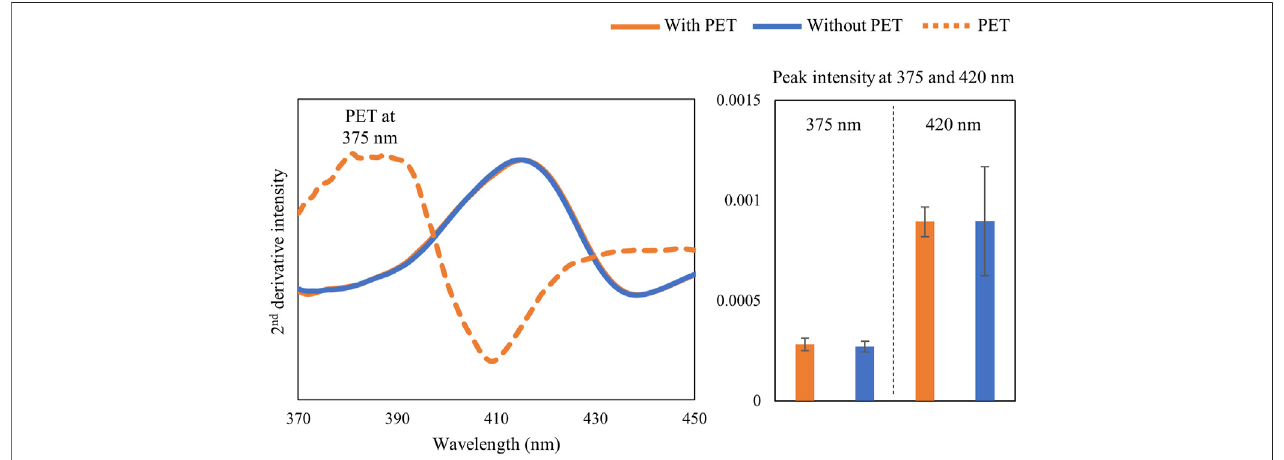
FIGURE4|(A) Saf-O-andfastgreen-stainedimagesfrom1-month( n =9)and3-month( n =6)animalswiththede fi nedrepairtissueregion. (B) Meanandstandard deviation of ICRS II component scores (comparisons by the Wilcoxon rank sum test, signi fi cance at p < 05).